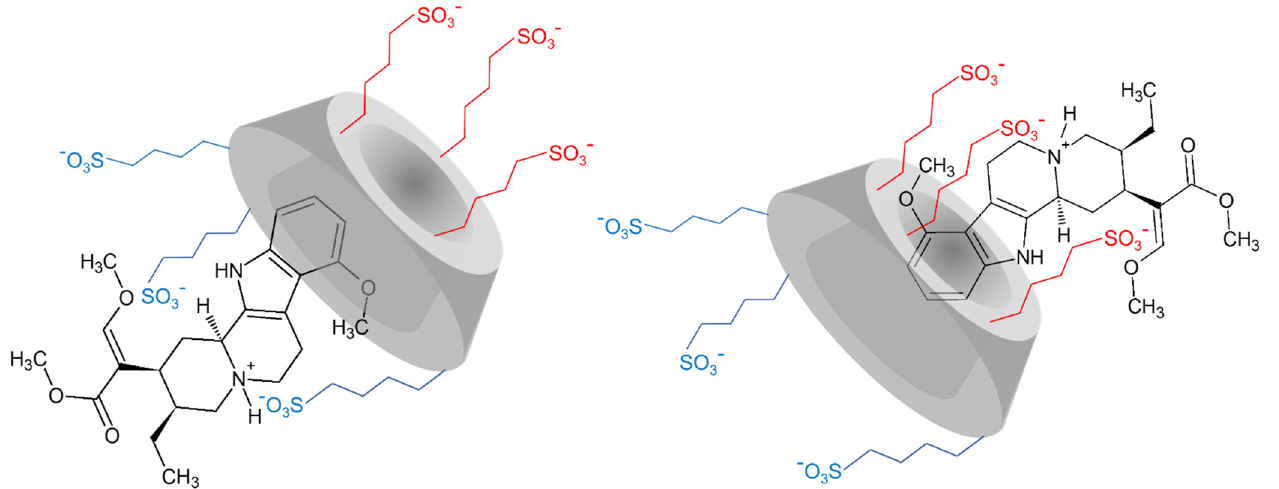
Figure 5. Suggested structure of the MTR · SBE β CyD inclusion complex based on the registered 2D ROESY NMR spectra and the CD spectroscopic experiments.